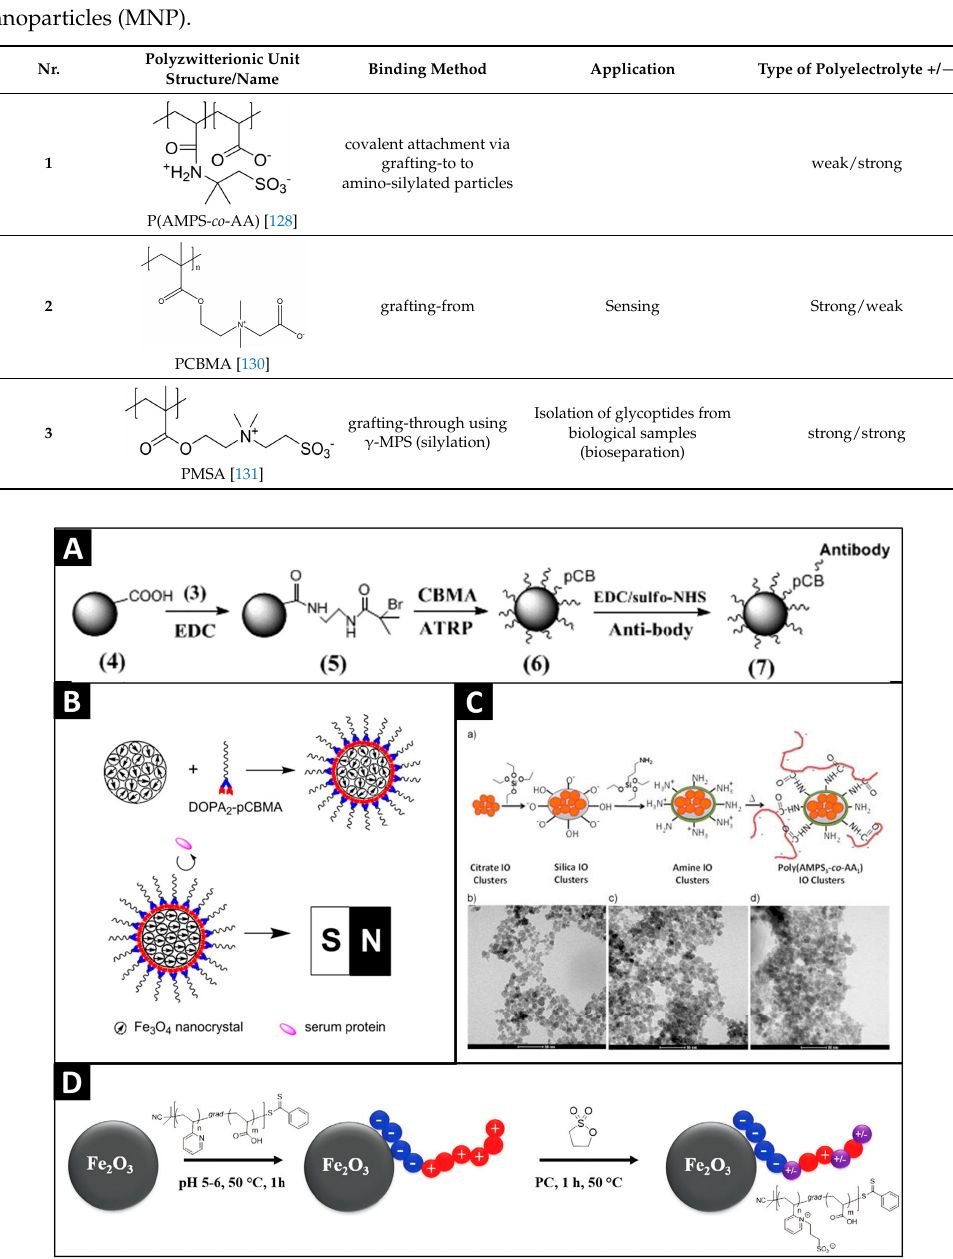
Figure 9. ( A ) Grafting-from approach for the polymerization of CBMA (carboxybetaine methacrylate). Reprinted from [130] with permission of ACS Publications; ( B ) Preparation of pCBMA-DOPA-2-MNPs and their magnetization in the presence of a permanent magnet. Reprinted from [135] with permission of Elsevier; ( C ) Scheme of the synthesis of poly(AMPS- co -AA) MNPs. Reprinted from [128] with permissions of ACS Publications; ( D ) Scheme of grafting-to of P(2VP- grad -AA) onto MNP and subsequent sultonation of P(2VP- grad -AA)@MNP, reprinted from [164] with permission of John Wiley and